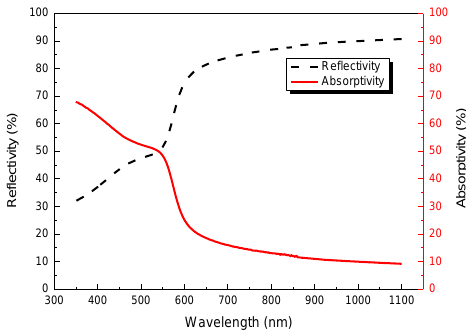
Figure 2. Absorption and reflectance curves of the Cu–Cr–Zr alloy tested at room temperature.